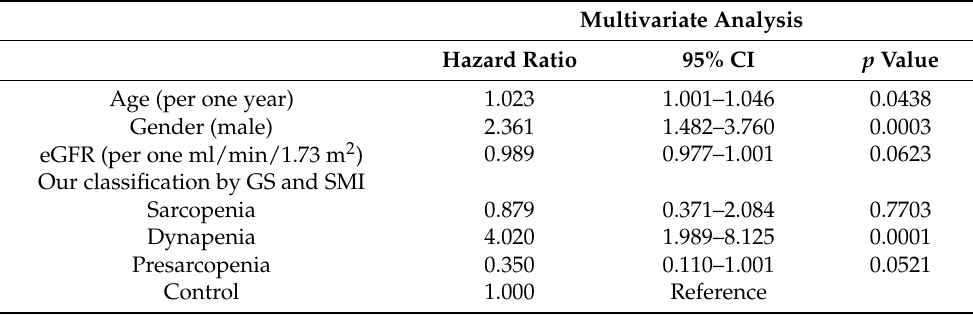
Table 3. Multivariate analyses of factors linked to the presence of metabolic